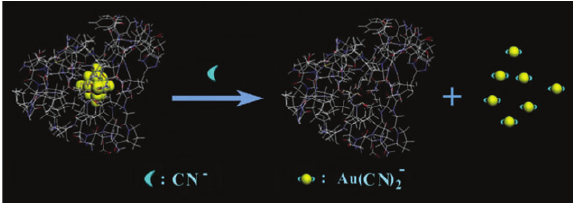
Figure 4 Schematic representation of the AuNC-based sensor for CN - . From Ref. [79]